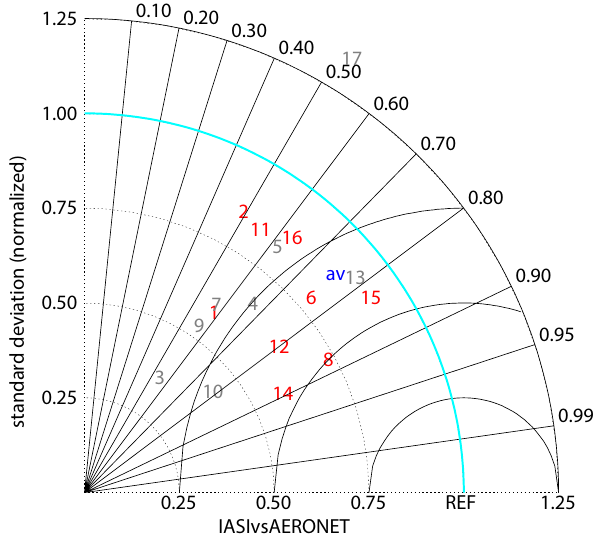
Figure 4. Same as for Fig. 2 except over land. Sites are identified by their number in Table 3.